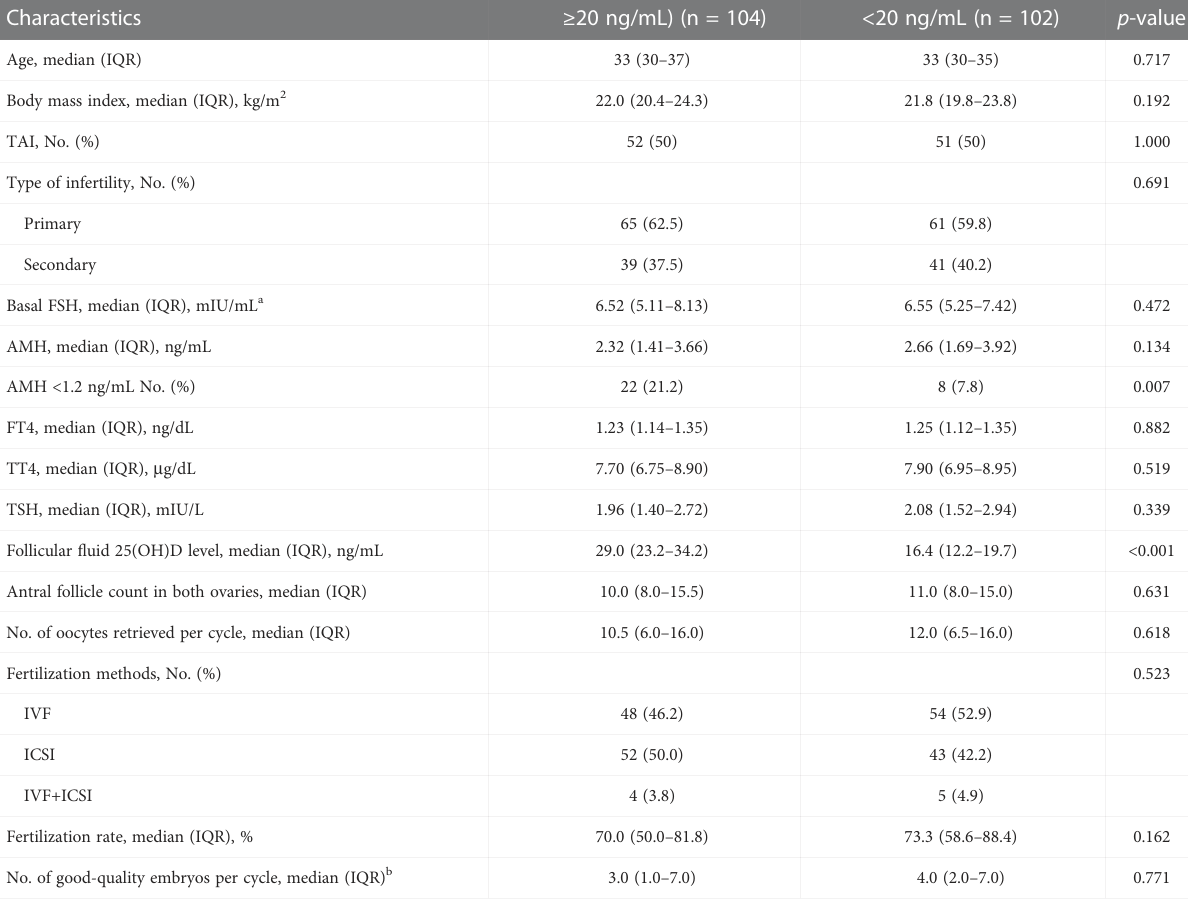
TABLE 2 Baseline characteristics and in vitro fertilization data of patients based on serum vitamin D status.